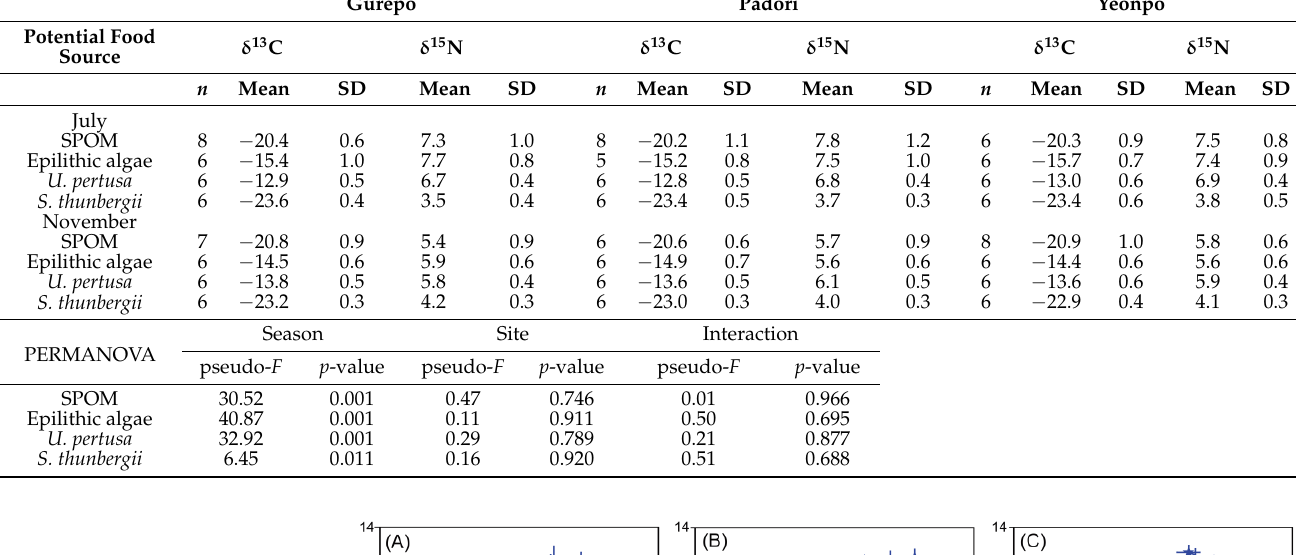
Table 1. Mean δ 13 C and δ 15 N values of potential food sources (SPOM, suspended particulate organic matter; Epilithic algae; U. pertusa , Ulva pertusa ; S. thunbergii , Sargassum thunbergii ) at the two heavily oil-impacted (Gurepo and Padori) and one non-impacted reference (Yeonpo) sites in July and November. PERMANOVA test of δ 13 C and δ 15 N values for each potential food source among the three sites and between the two seasons (significance at p < 0.05). Data represent means ± 1 SD. Gurepo Padori Yeonpo